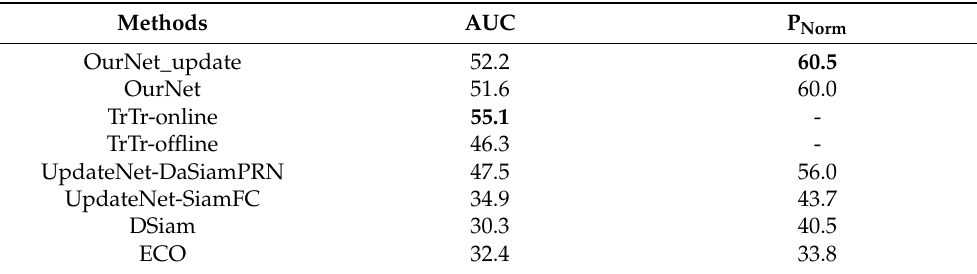
Table 1. Performance results of SOTA tracker with an update mechanism on the LaSOT